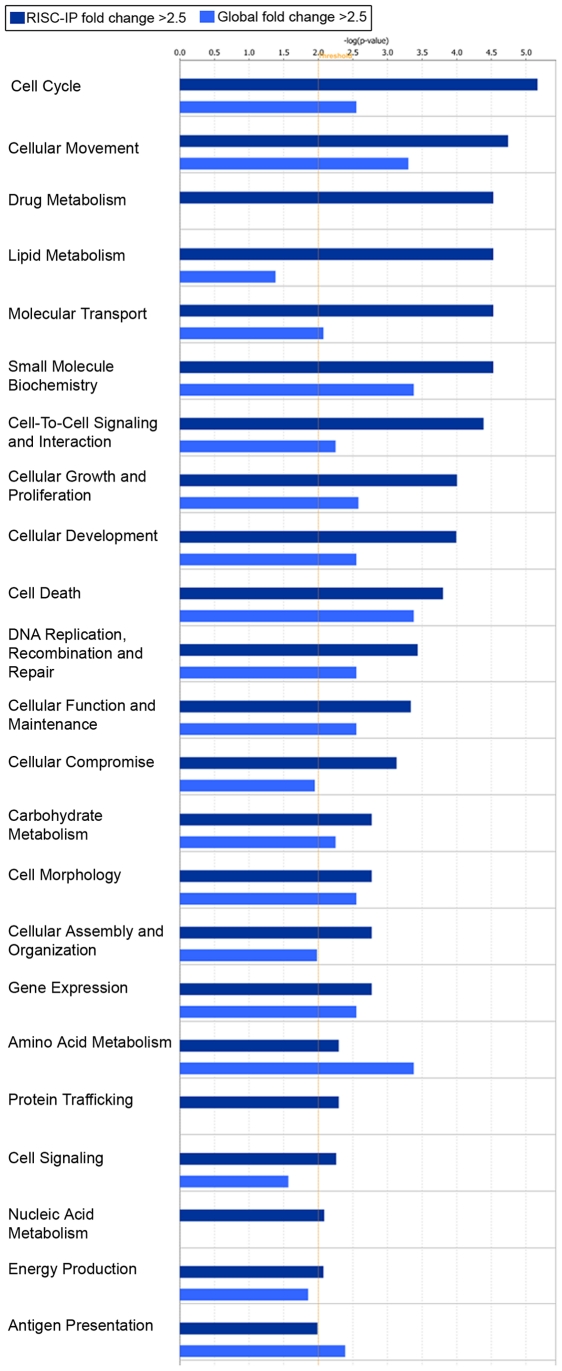
Molecular and cellular functional assessment of the mRNA in the RISC of U-87 astrocytoma cells compared to primary astrocytes and the mRNA in the global cellular milieu of U-87 astrocytoma cells compared to primary astrocytes.Bar charts display the relative number (-log(p-value)) of mRNAs with a fold change >2.5 and were considered significant (p<0.01). RISC-IP mRNA were indicated with dark blue bars and the global mRNA were indicated with light blue bars. The threshold (yellow lines) were set at p<0.01 and were calculated using Fischer's exact p-value test using IPA software.